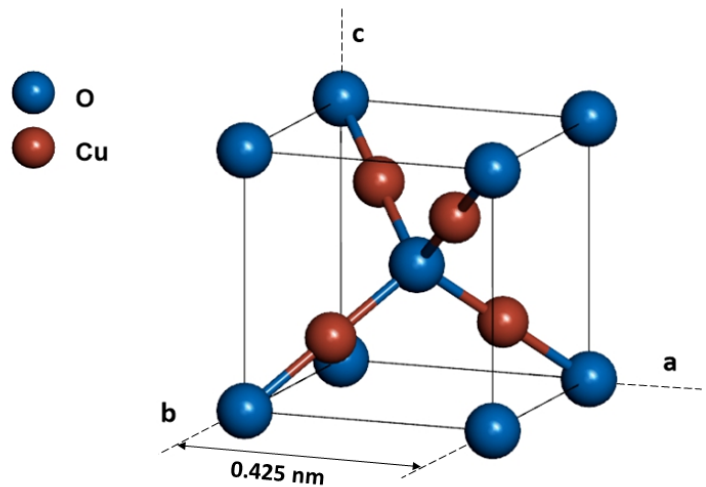
Figure 1. Unit cell of Cu 2 O, prepared based on JPCDS card # 01-074-1230.